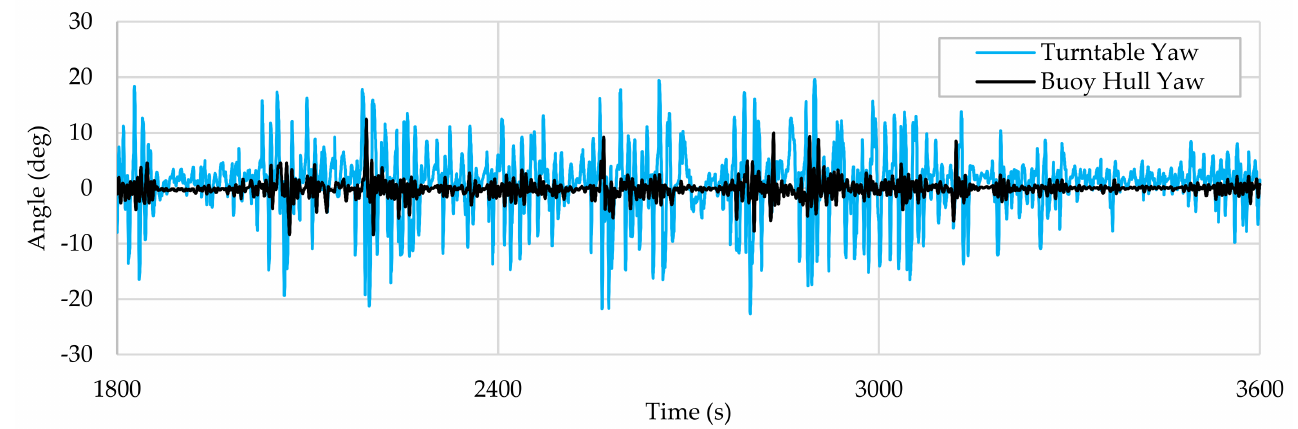
Figure 9. Yaw angle of mooring buoy and turntable: 50 y, heading 0 deg., coupled.